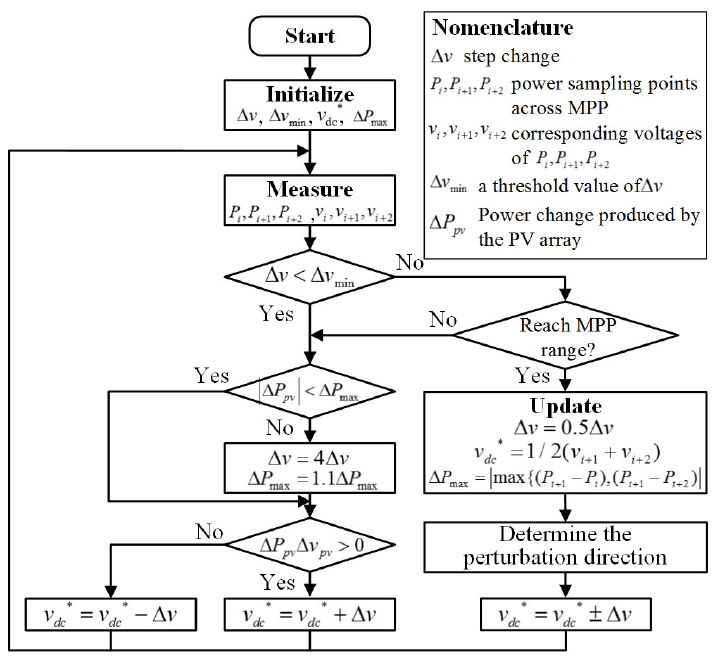
Figure 4. Flowchart of the improved MPPT (maximum power point tracking)